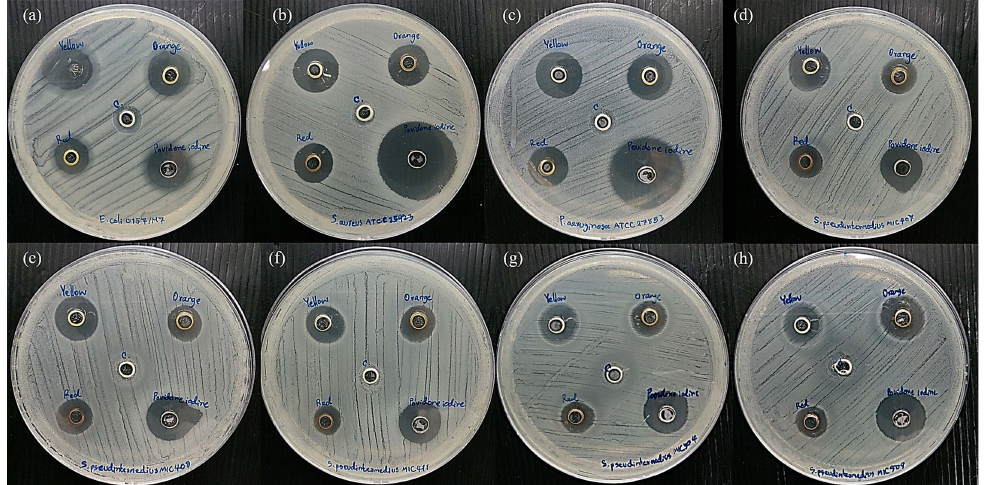
Figure 5. Antimicrobial activity of the AgNP gel determined by the well diffusion method. The AgNP gel (S1 [yellow], S2 [orange], S3 [red]), povidone iodine and control gel were dropped into wells and incubated with pathogens for 24 h at 37 ◦ C. The inhibition zones were measured in mm in diameter. ( a ) E. coli , ( b ) S. aureus , ( c ) P. aeruginosa , ( d – h ) S. pseudintermedius MIC 407, 408, 411, 504, 509,